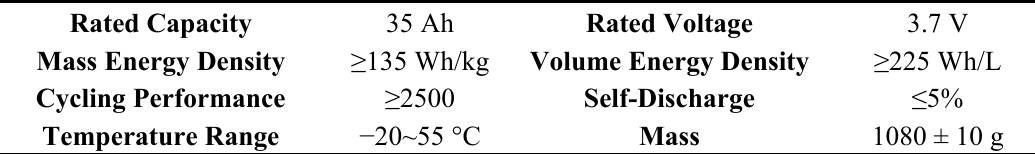
Table 3. The main parameters of the chosen battery cells.